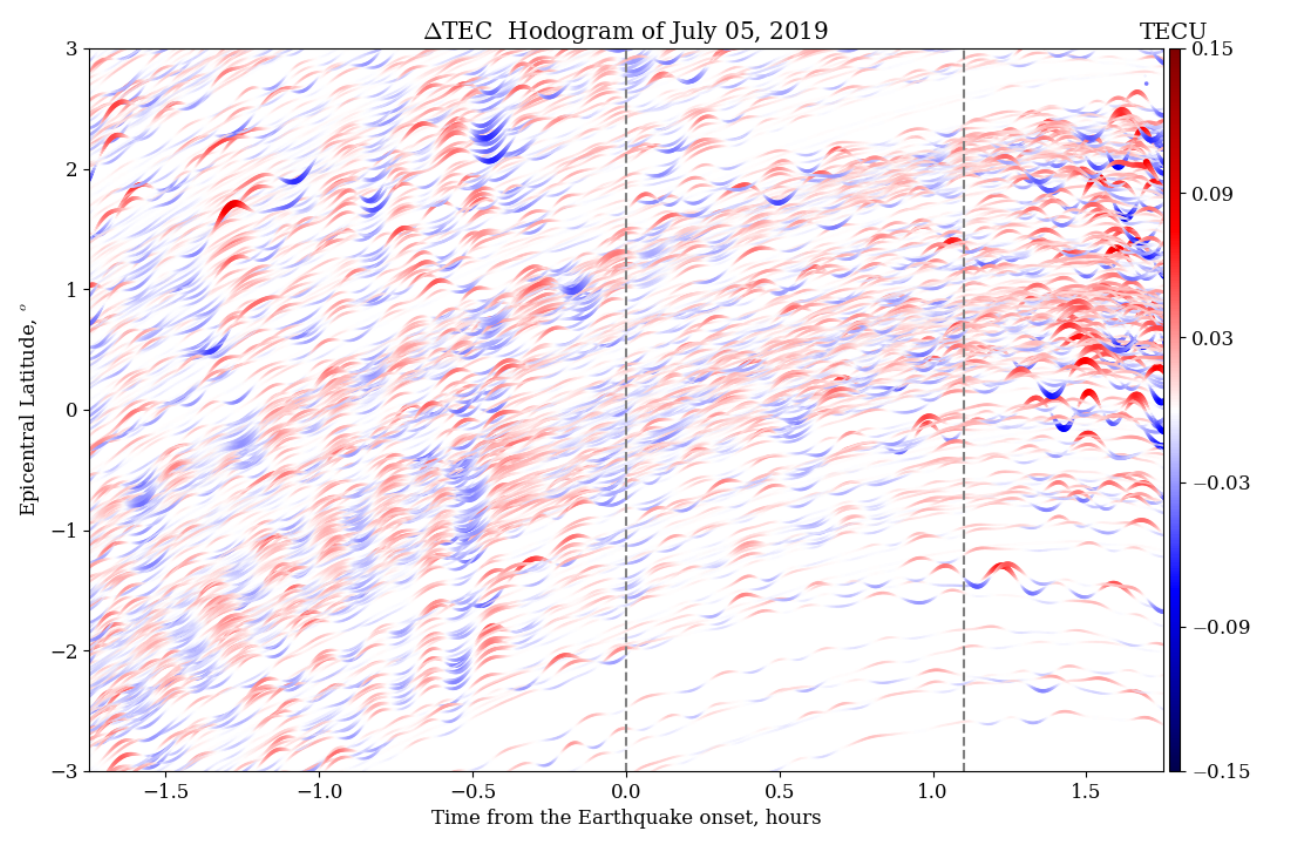
Figure 7. Hodogram of observed ∆ TEC on the day after the